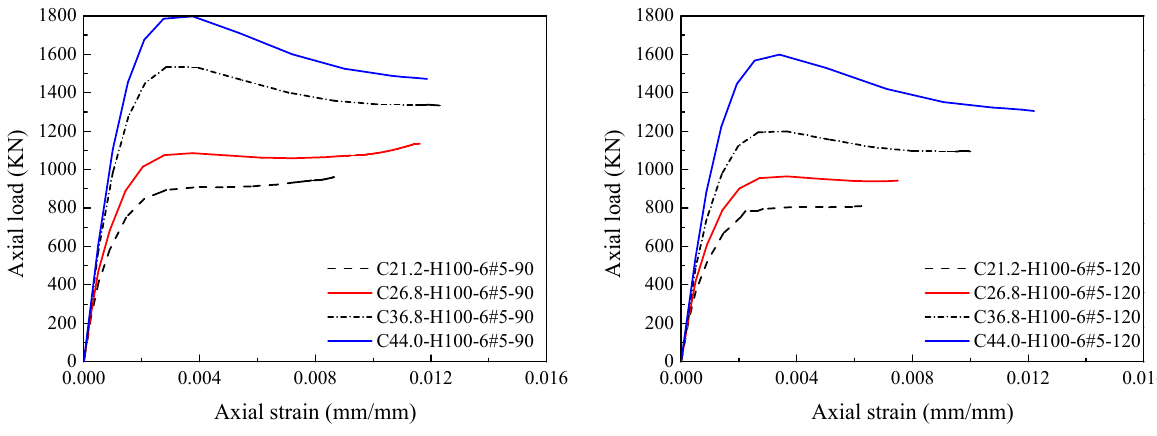
Figure 20. Effect of varying compressive strengths of concrete on the load-strain response of HCCs.